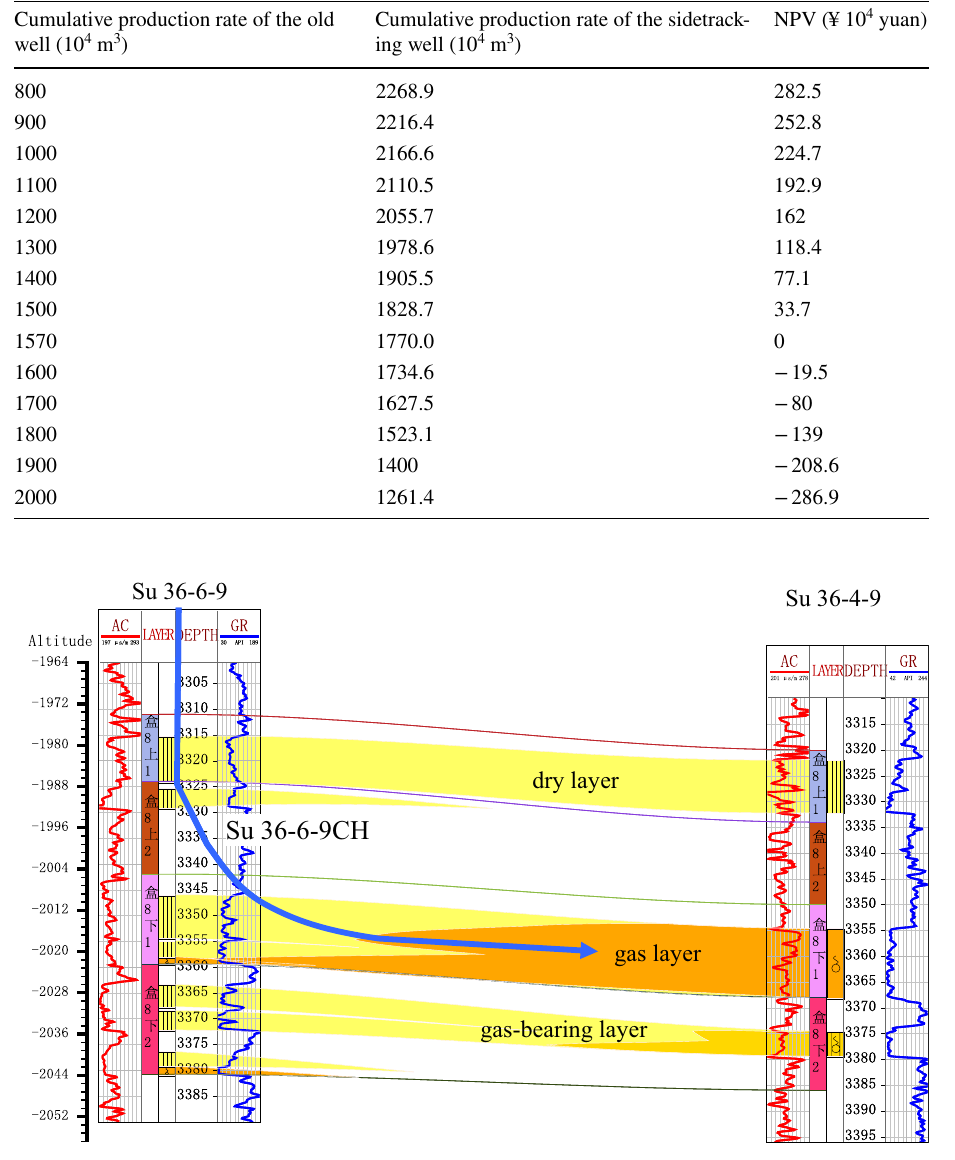
Fig. 9 Prediction of sidetracking well accumulative production rate under different old gas well cumulative production rate